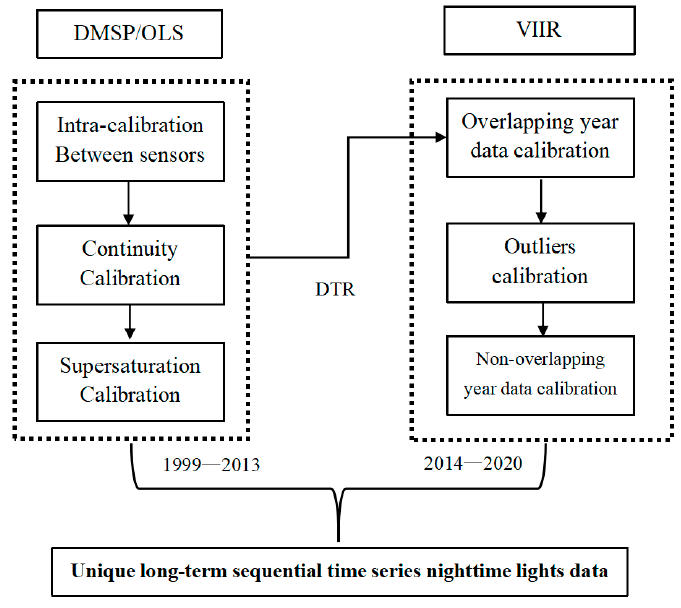
Figure 3. Procedures for the NTL data calibration.